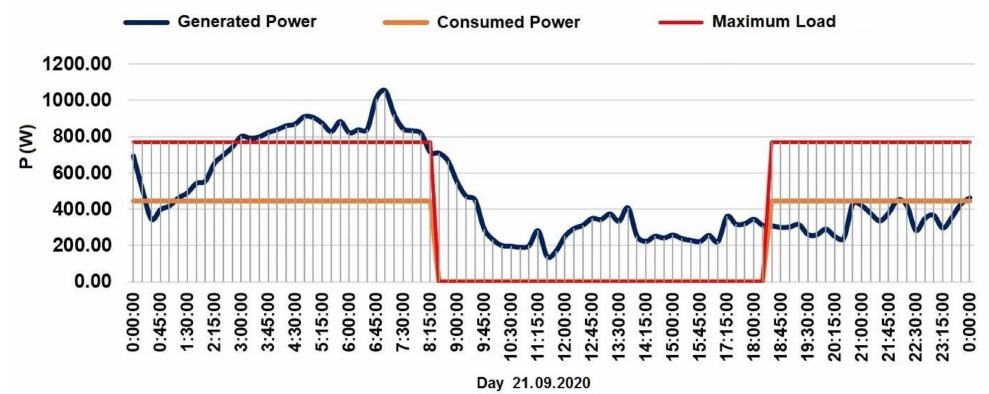
Figure 13. Energy produced and consumed on the average generation day and a calculation of the transposition of all the energy generated to the nighttime hours of use of the